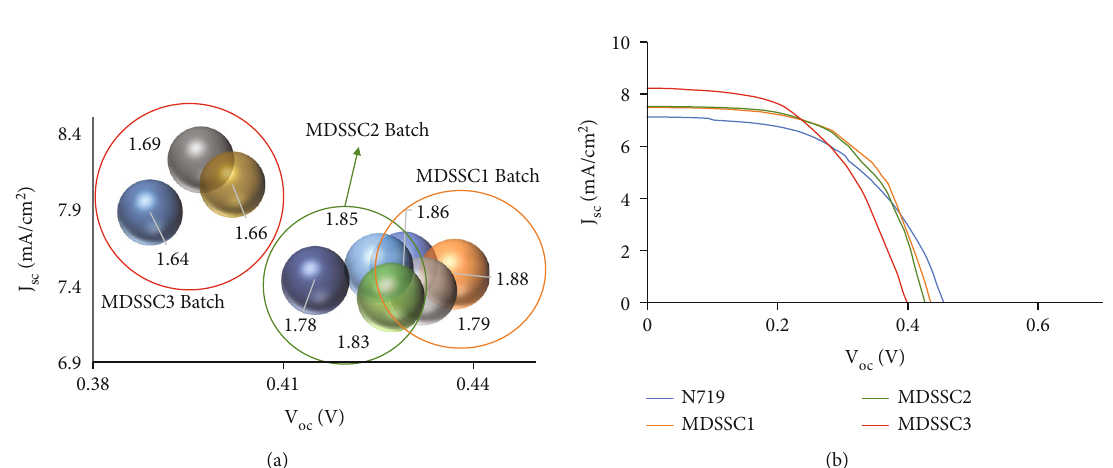
V sc and oc of the MDSSC batches (the diameter of bubbles showed the e